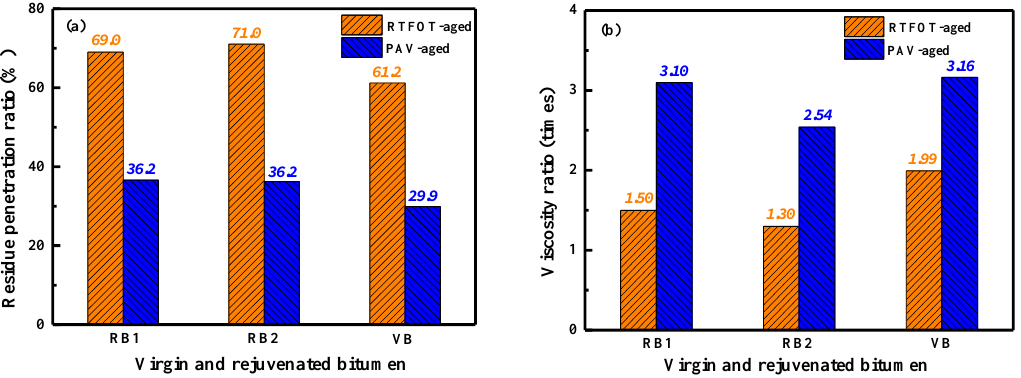
Figure 13. The aging properties of virgin and rejuvenated bitumen.